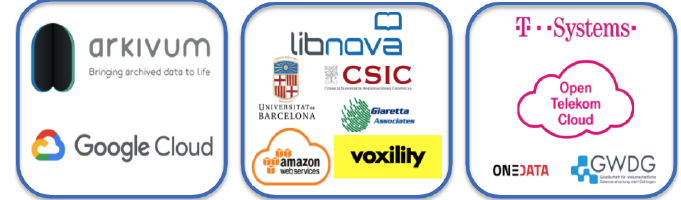
Fig. 5. Selected Consortia for the Prototype